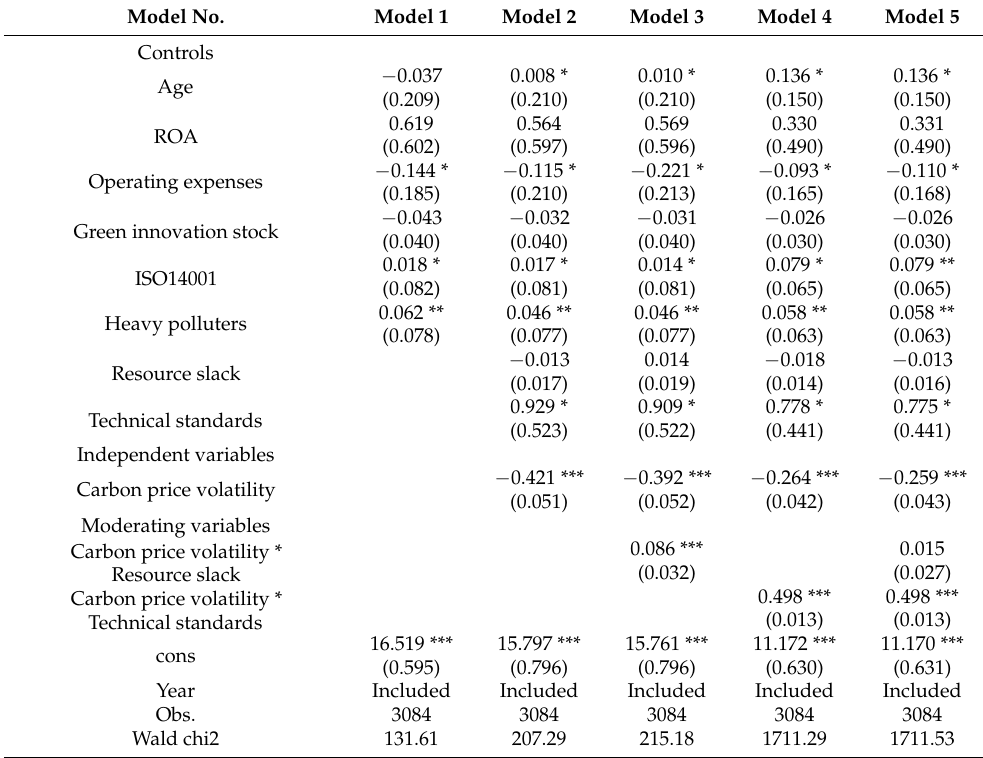
Table 2. The random-effect Tobit model of the green